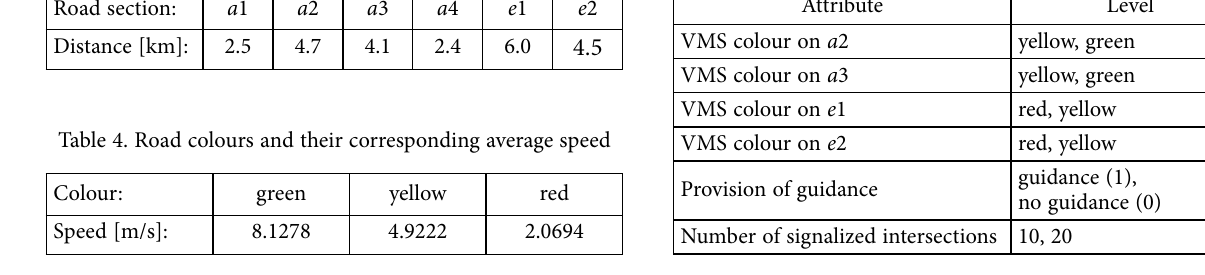
Table 3. Distance corresponding to road sections Road section: a 1